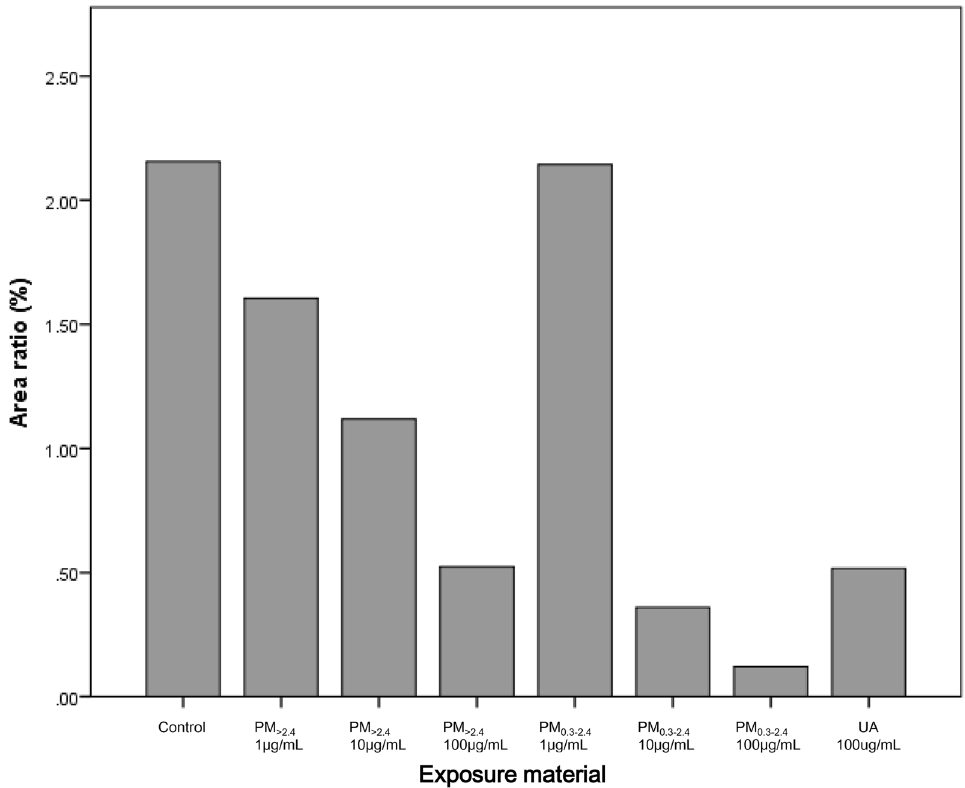
Figure 7. Area ratio of expression of ZO-1 in representative immunostained reconstructed human corneal epithelial tissues. This figure was created using the software SPSS Statistics 24.0 (https ://www.ibm.com/produ cts/spss-stati stics ?lnk=STW_US_STESC H_P1_BLK&lnk2=trial _SPSSs tat&lot=1&pexp=def&psrc=none&m hsrc =ibmse arch_a&mhq=spss). ZO-1 zonula occludens-1, PM > 2.4 particle matter larger than 2.4 µm, PM 0.3–2.4 particle matter 0.3–2.4 µm, UA urban